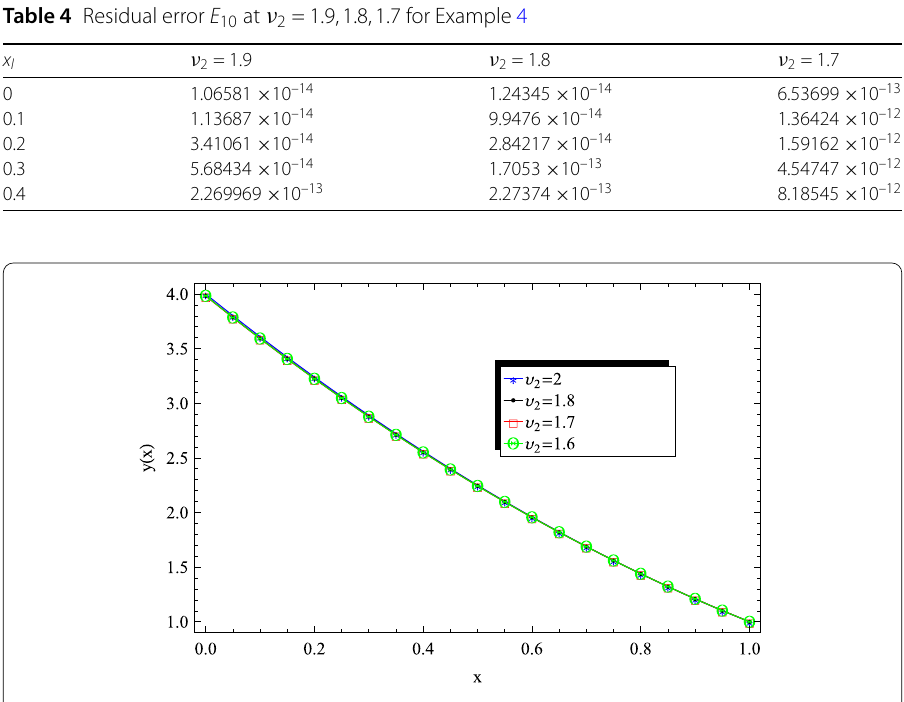
Figure 1 Comparison of y ( x ) for N = 4 with ν 2 = 2, 1.8, 1.7, and 1.6 for Example